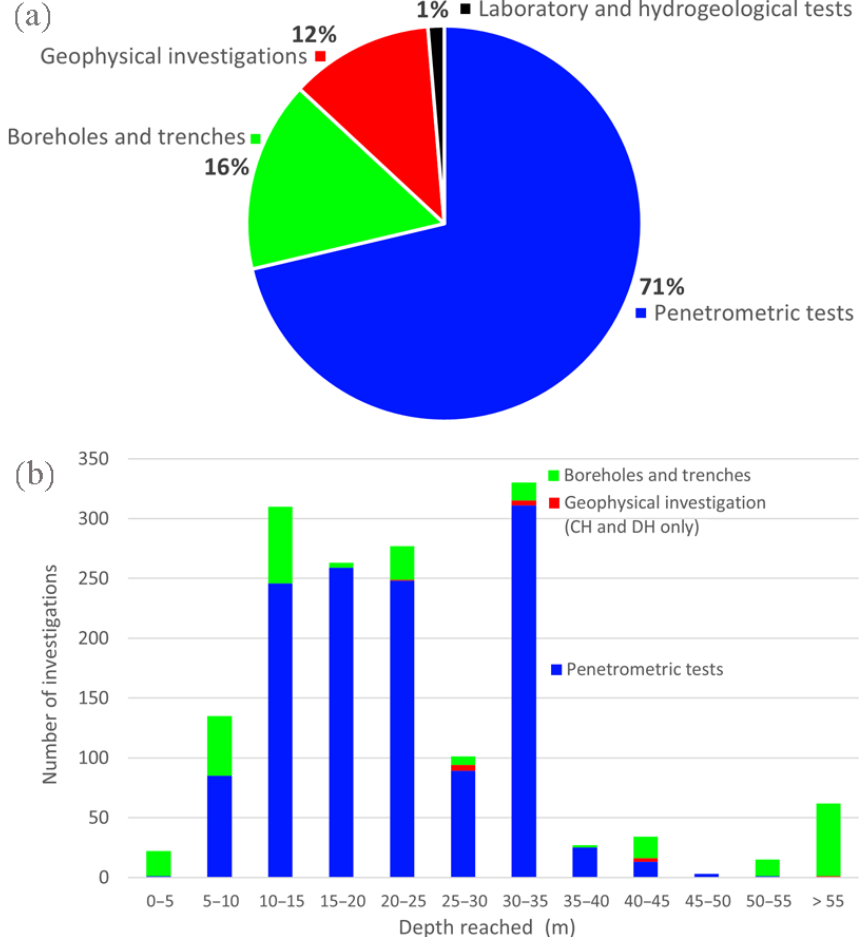
Figure 4. PERL dataset characteristics. (a) Classes of in situ investigations and (b) depth reached by penetrometer tests, geophysical inves- tigations (CH and DH), boreholes, and trenches.